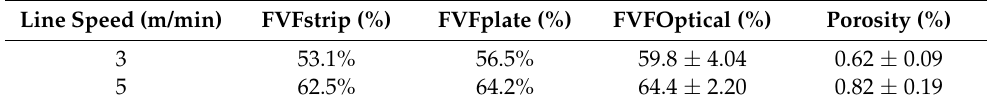
Table 2. FVF values of the composite plates, estimated by optical microscopy.